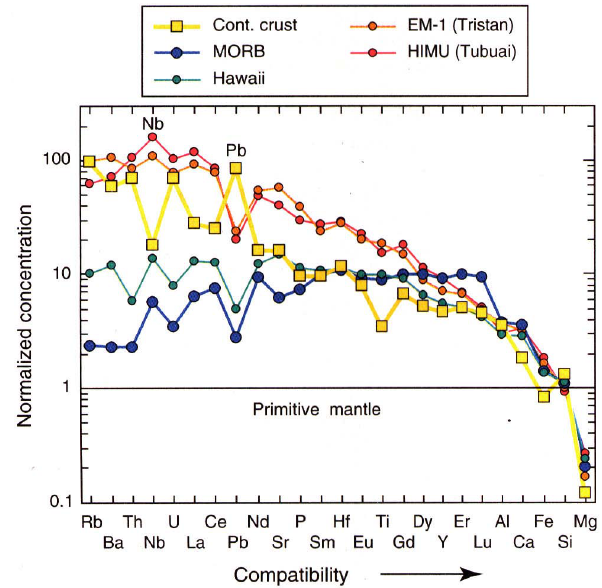
Fig. 3. Trace element concentrations in mantle-derived rocks. Con- centrations are normalised to estimated concentrations in the prim- itive mantle. From Hofmann (1997). Reprinted from Nature with permission. Copyright Macmillan Magazines